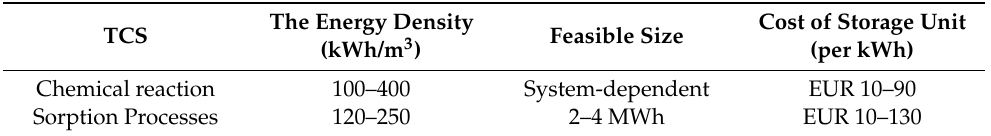
Table 5. Characteristics of TCS